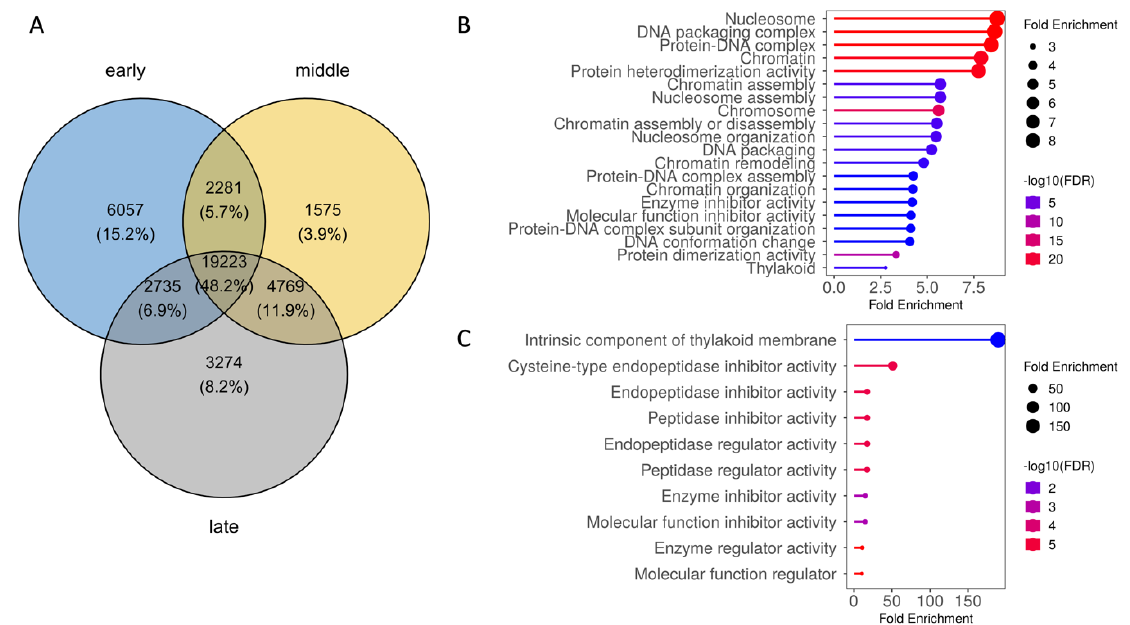
Figure 3. Characteristics of transcripts expressed during the early, middle, and late stages of seed development. ( A ) Venn diagram of genes expressed (TPM > 2) in specific stages of triticale seed development: early (10 dpa), middle (15 dpa), and late (20 dpa). ( B ) and ( C ) GO enrichment analysis of reference genes expressed during early and middle stages of seed development, respectively.